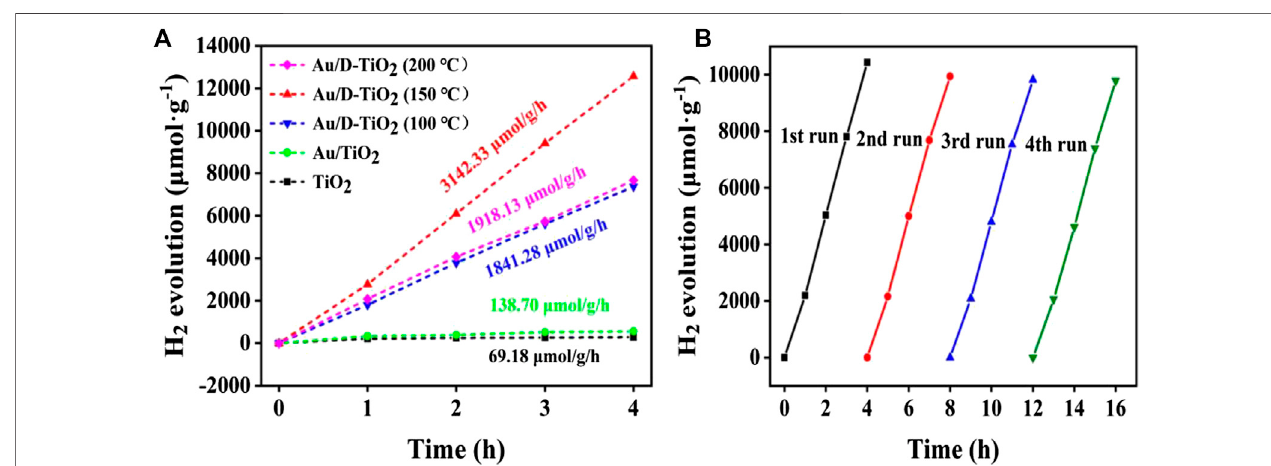
FIGURE 7 | (A) H 2 production of TiO 2 , Au/TiO 2, and Au/D-TiO 2 (The D-TiO 2 were treated at 100 ° , 150 ° , and 200 ° C, respectively) under sunlight irradiation (B) Circulation experiment of hydrogen evolution of Au/D-TiO 2 (treated at 150 ° C).